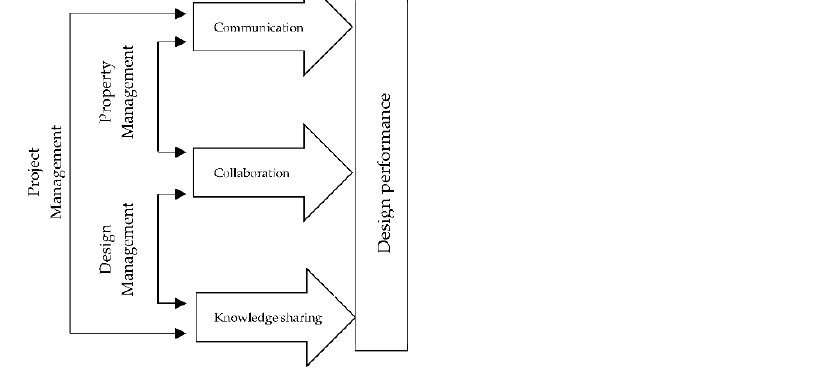
Figure 4. Positive relationship of factors to design performance according to each stakeholder.